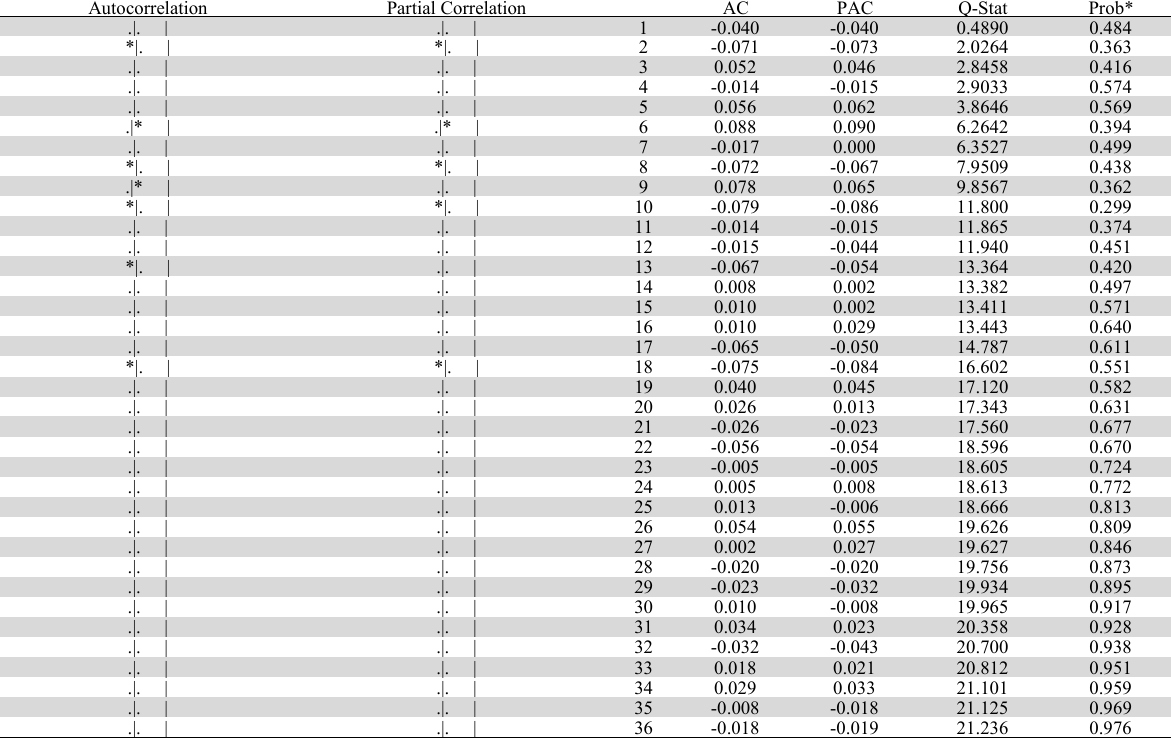
Exhibit the Post Estimation Model Output of Residual Diagnostics Correlogram Squared Residuals Statistics Autocorrelation Partial